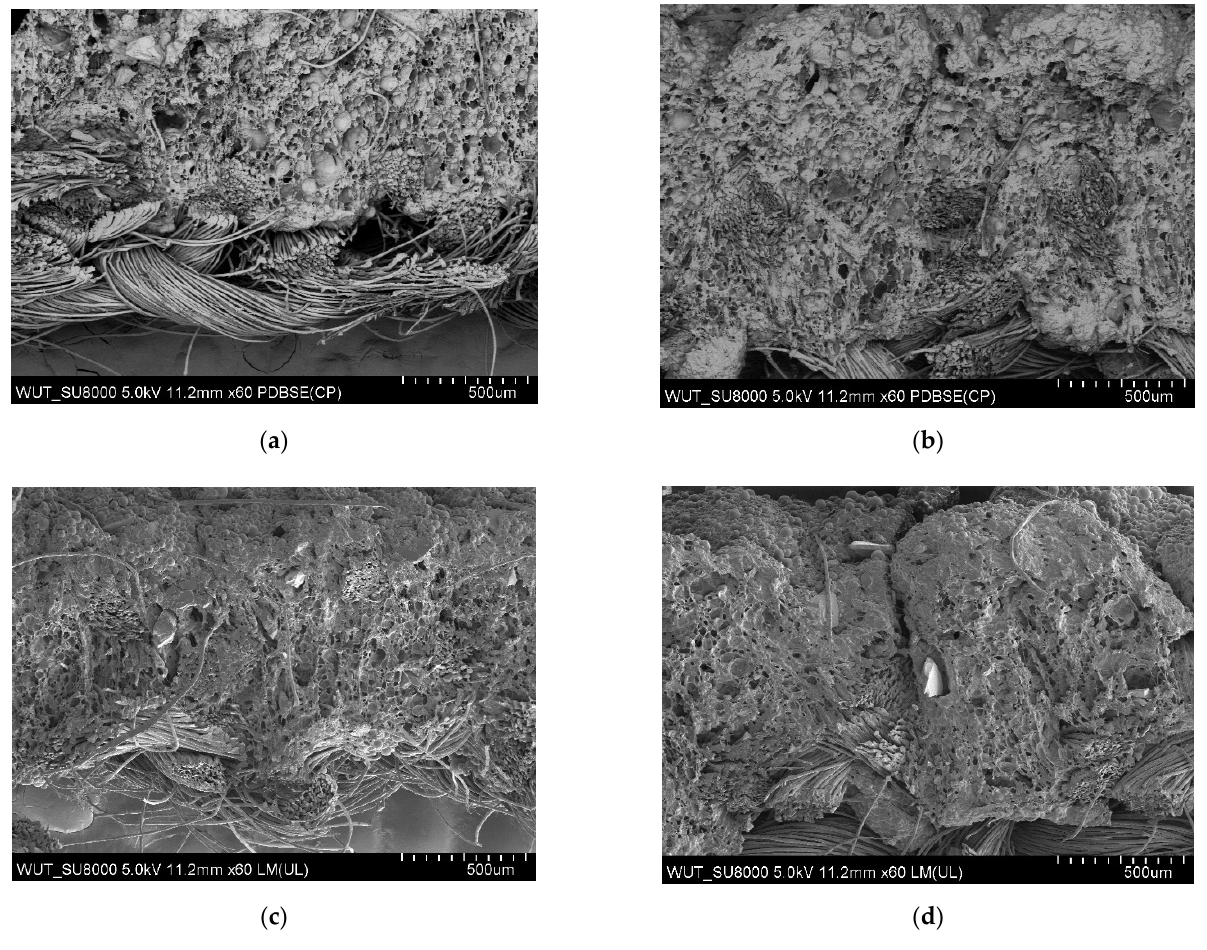
Figure 4. ( a ) SEM image of coating incorporating Al 2 O 3 with a particle size of 710–750 µm (additive 1). ( b ) SEM image of coating incorporating Al 2 O 3 with a particle size of 180–250 µm (additive 2). ( c ) SEM image of coating incorporating Al 2 O 3 with a particle size of 100–500 µm (additive 3). ( d ) SEM image of coating incorporating Al 2 O 3 with a particle size of 50–56 µm (additive 4).